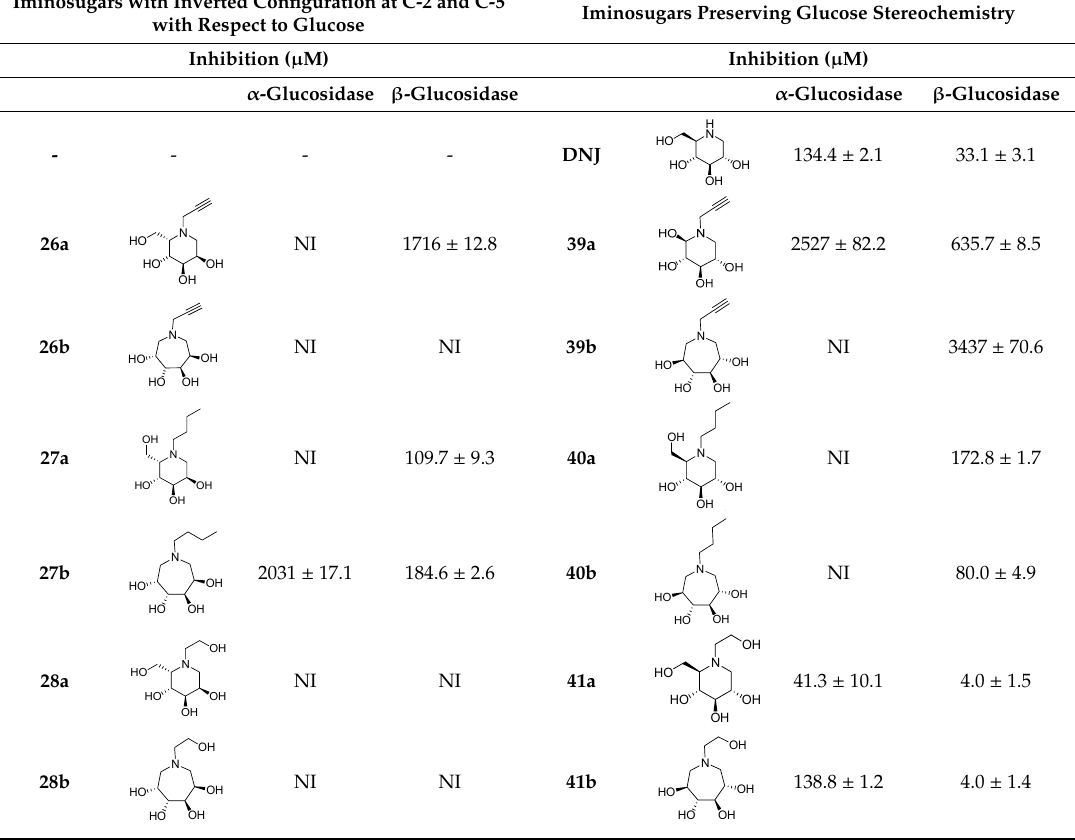
Table 2. α - and β -Glucosidase activities of synthesized iminosugars having alternative stereochemistry, ring size, and N -alkyl and N -arylalkyl chains on the endocyclic nitrogen. Iminosugars with Inverted Configuration at C-2 and C-5 with Respect to Glucose